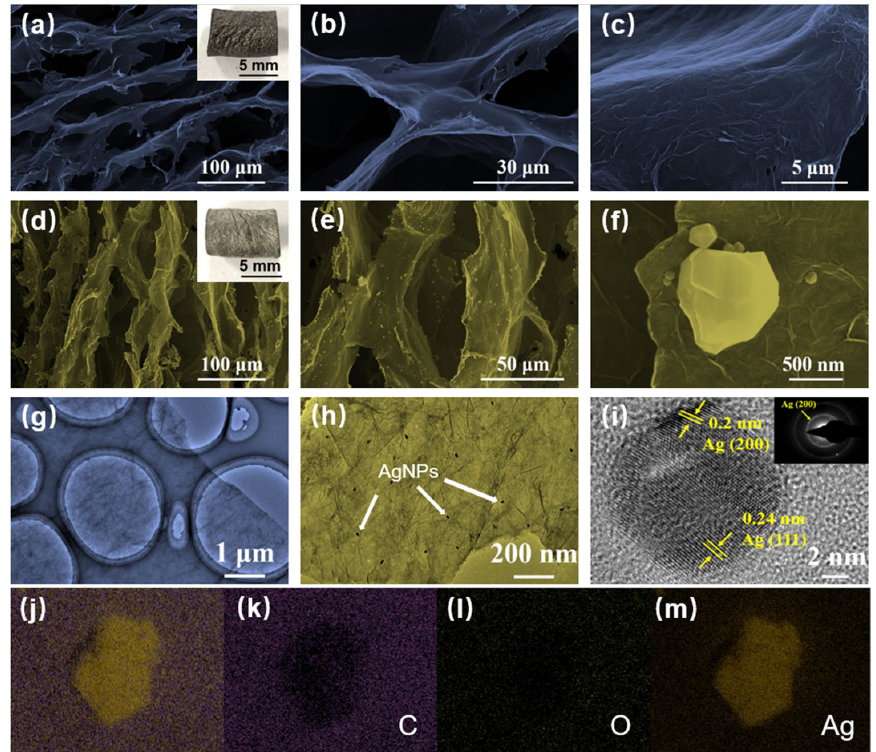
Figure 2. Microstructural characterization. ( a – c ) SEM image of 3D graphene scaffolds at different scales. ( d – f ) SEM image of the graphene hybrid AgNPs device at different scales. ( g – i ) TEM images of the graphene sheet’s wrinkling morphology and AgNPs crystal structure. ( j – m ) Element mapping for C, O and Ag.